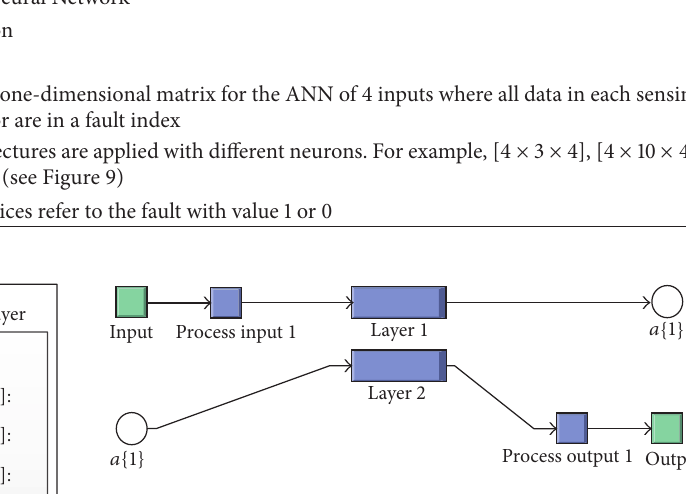
Figure 8: Internal architecture of Neural